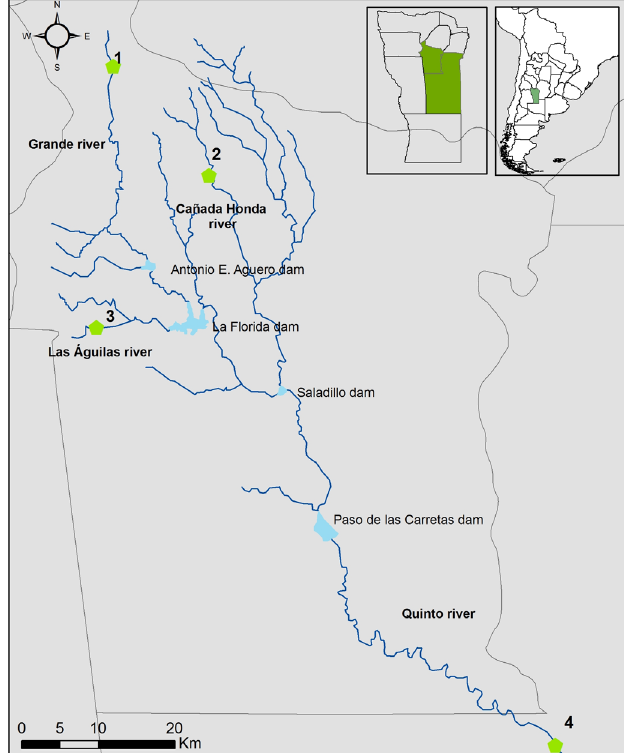
B. huaico Figure 5. Nymph of . (t) tubercle, abdomen, lateral view.